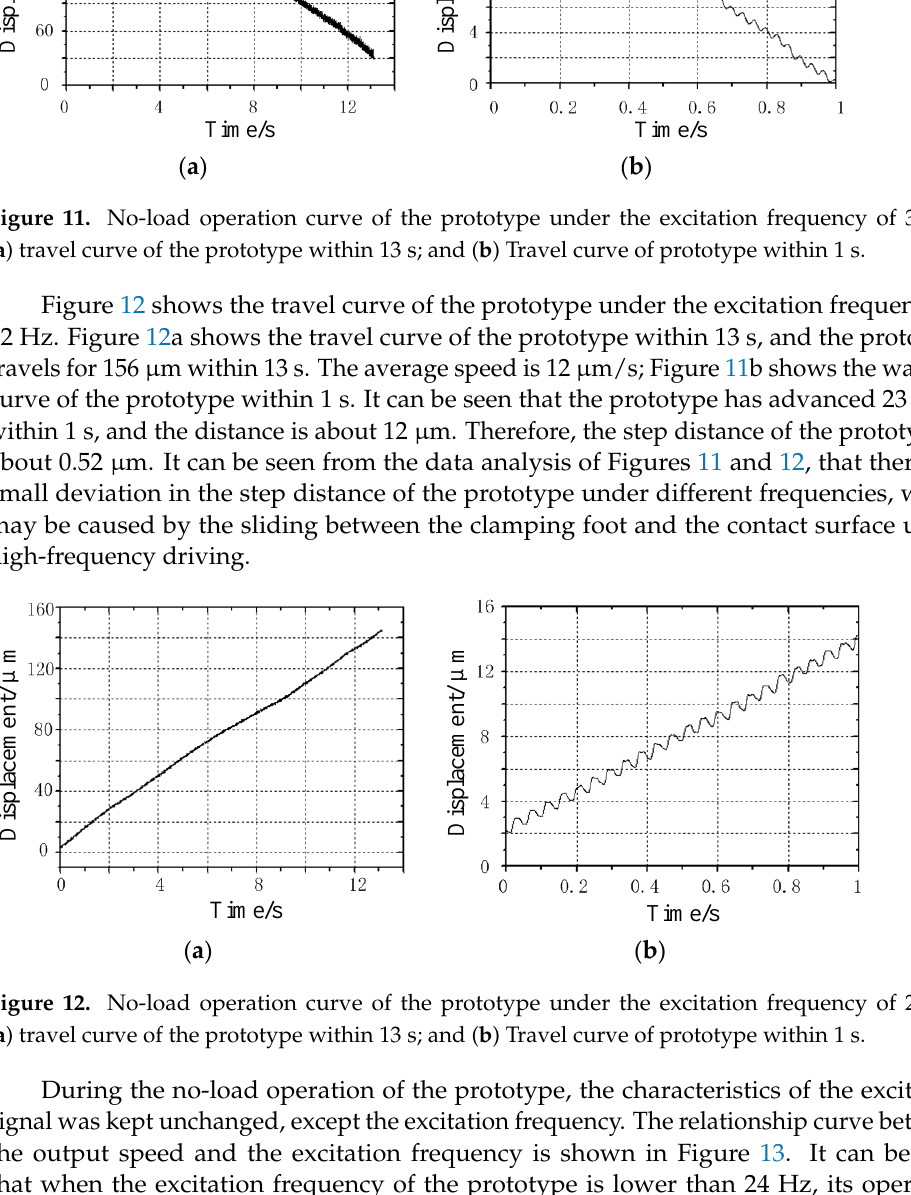
Figure 13. Moving speed versus driving frequency.